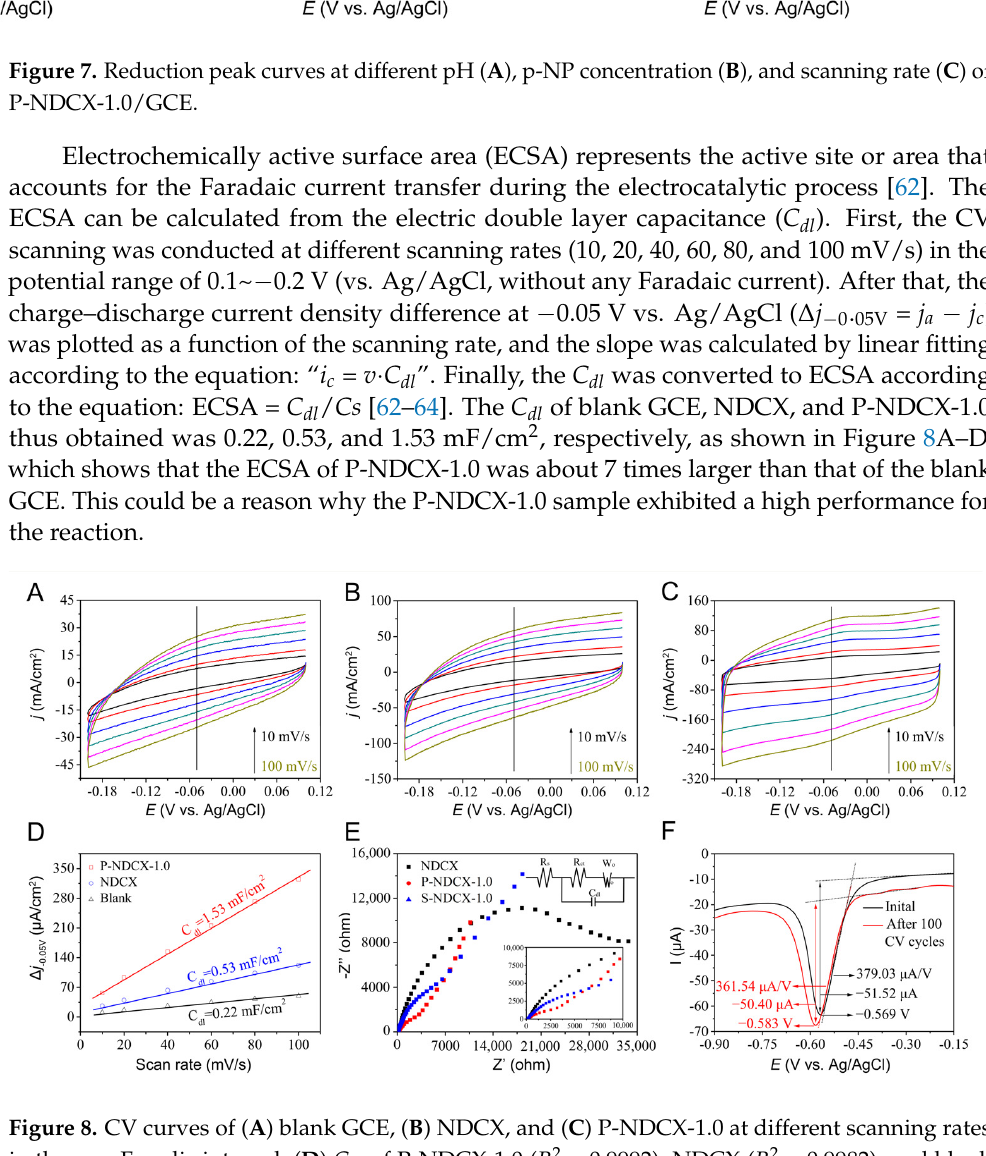
Figure 7. Reduction peak curves at different pH ( A ), p ‐ NP concentration ( B ), and scanning rate ( C ) of P ‐ NDCX ‐ 1.0/GCE.